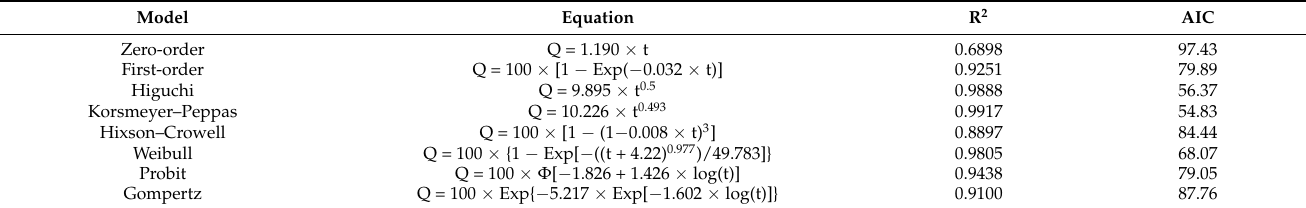
Table 2. Release kinetics model